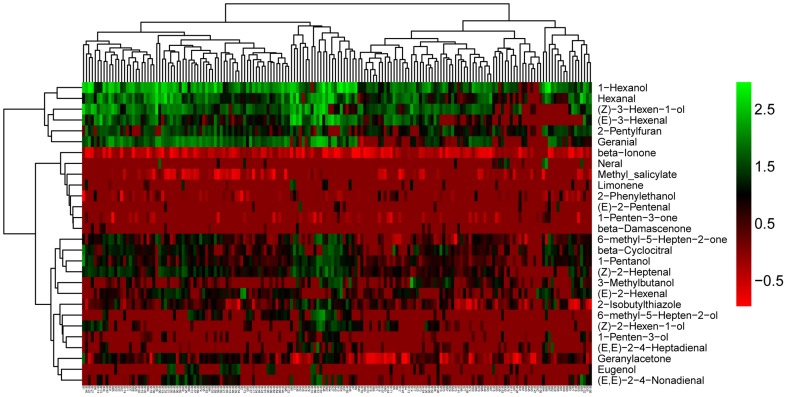
Cluster analyses of the 28 selected volatiles among the whole accessions. The names of volatiles (right) and the accession codes (bottom) are shown (The accession codes can be seen in Table S1).